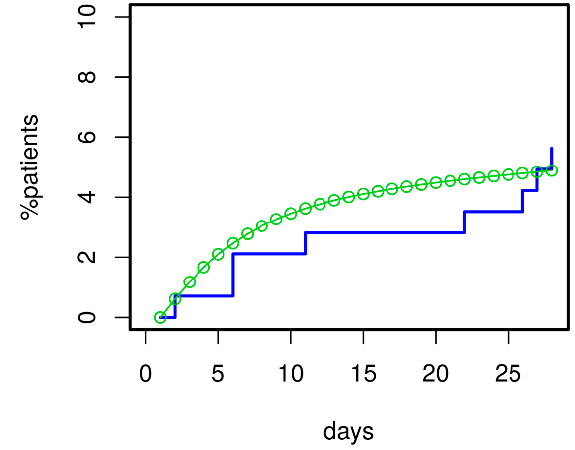
Figure 8. Model validation regarding 28 d mortality was performed using the severely ill CAP patients (ssCAP sub-cohort) of PROGRESS. Predictions and data were in good agreement. Moreover, the model correctly predicted the increased mortality of ssCAP patients compared to PROGRESS patients with mostly lower initial CAP severity used for model calibration (compare with Figure 6).